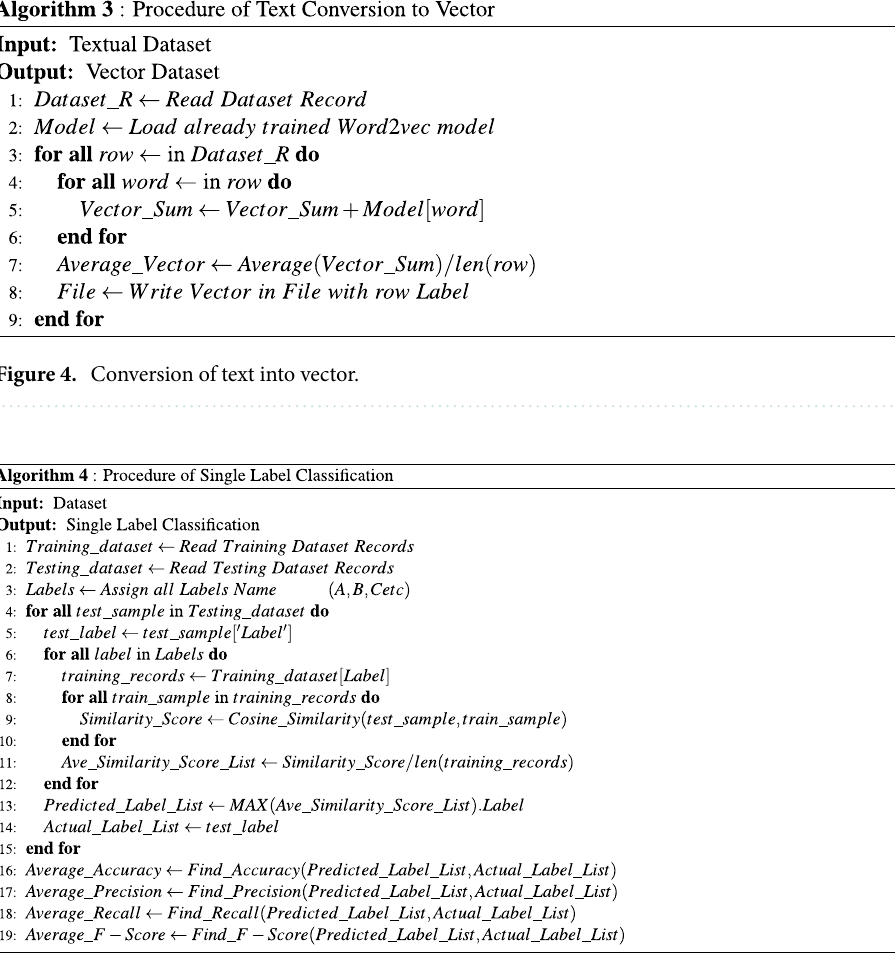
Figure 5. Procedure of single label